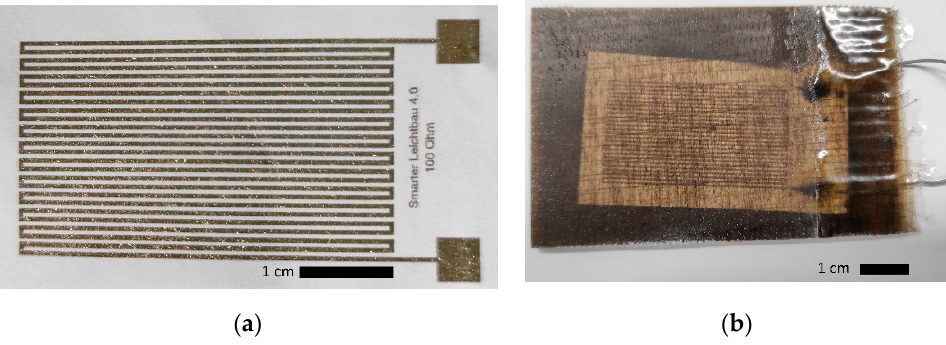
Figure 4. ( a ) Printed temperature sensor on the paper substrate; ( b ) bottom view of integrated sensor sample.